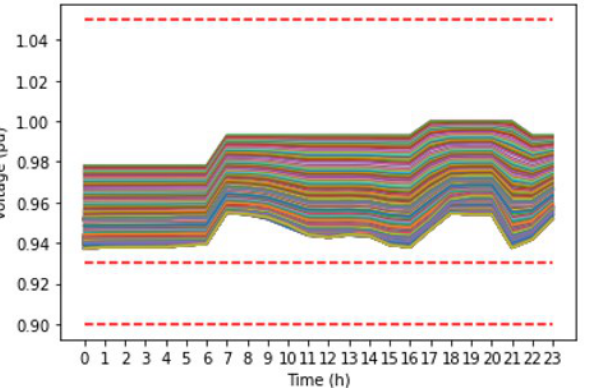
Figure 17. Behavior of the battery for the active distribution network scenario with increase charge.